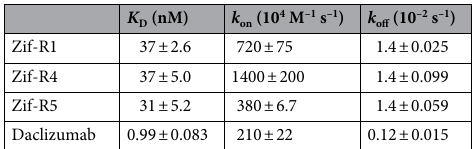
Table 1. Binding kinetics of Zif-FLAPs and daclizumab to CD25.